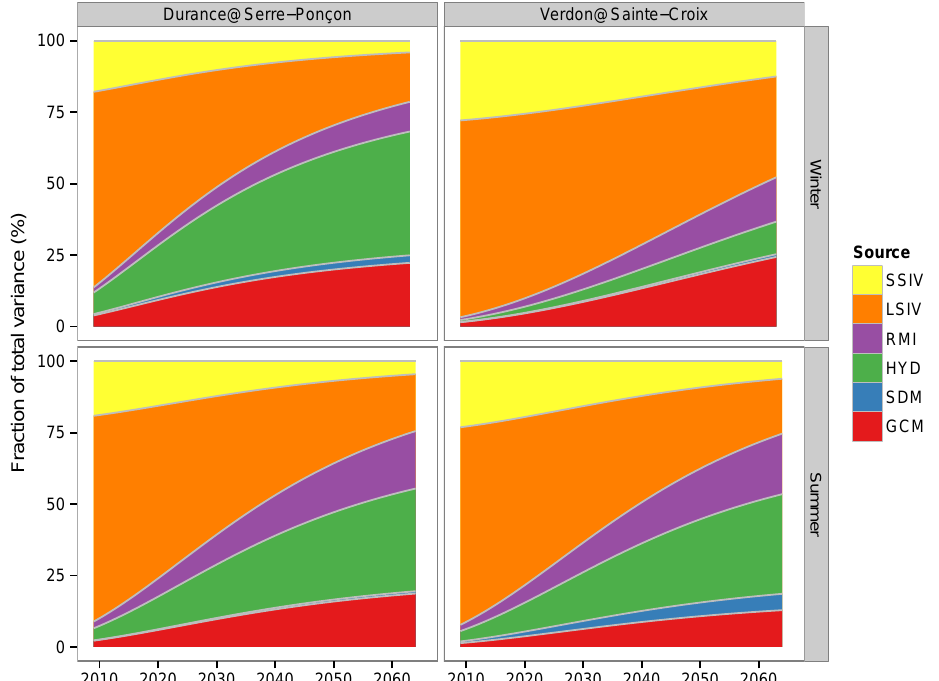
Figure 7. Fraction of total variance explained by each source of uncertainty for 30-year rolling averages of low-flow changes with respect to the REF period average. Values are plotted in the middle of each time